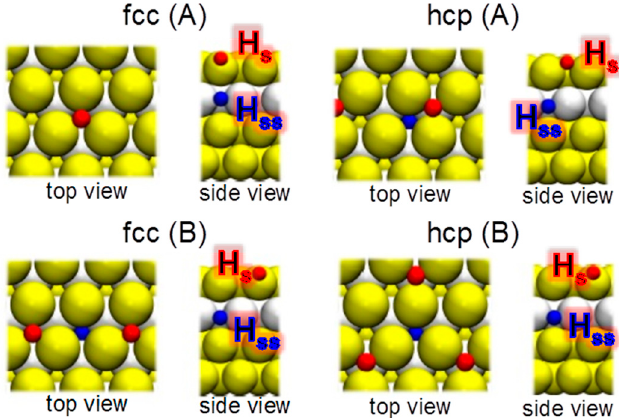
Figure 5. Top and side views for small coverages of the adsorbed and absorbed hydrogen ( θ (H ss ) = 0.25, θ (H s ) = 0.25).